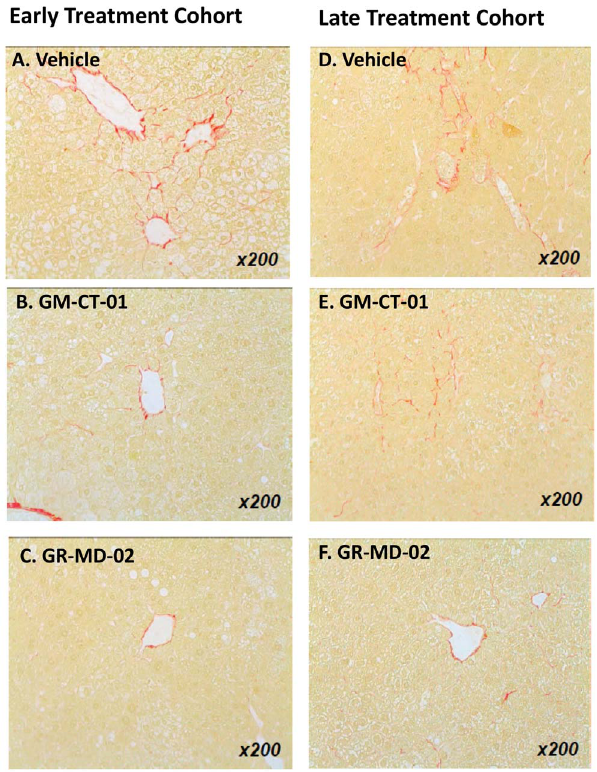
Figure 3. Liver histology stained with Sirius red. Early and late treatment cohorts were administered intravenously twice weekly